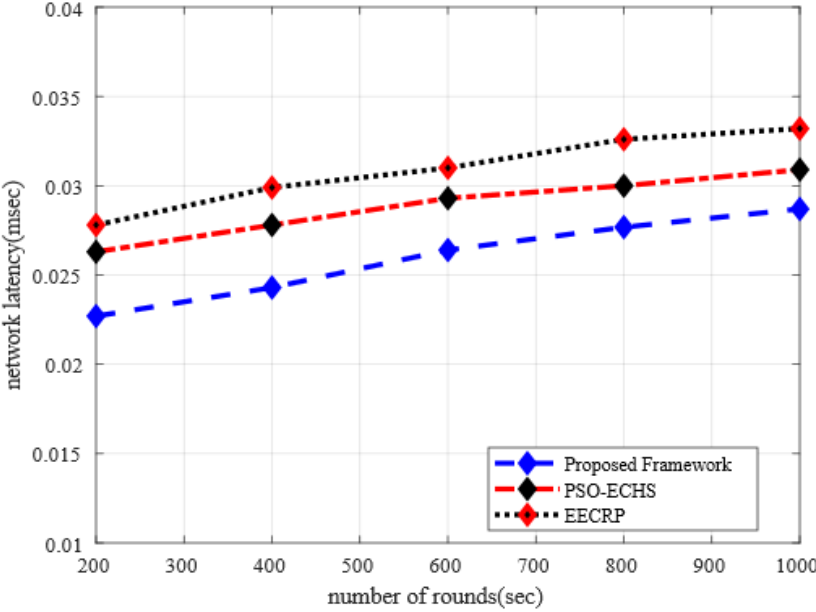
Figure 5. The impact of the simulation rounds on network latency.